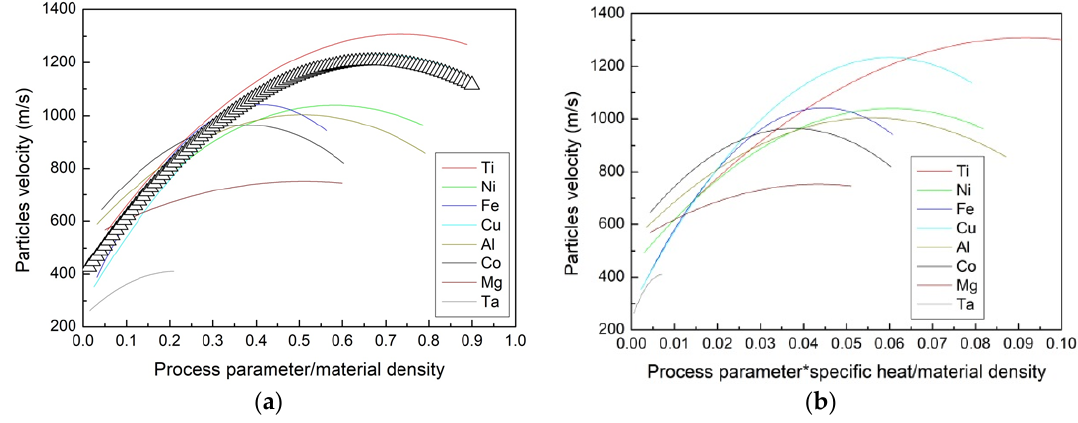
Figure 5. ( a ) Relationship between the particle velocity and ( b ) the process parameter normalized over the particle density. The black triangles define the common fitting curve.